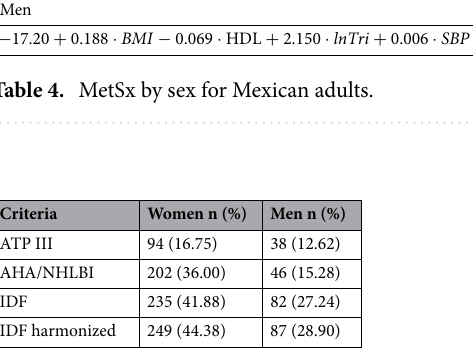
Table 5. Prevalence of metabolic syndrome according to the different criteria.